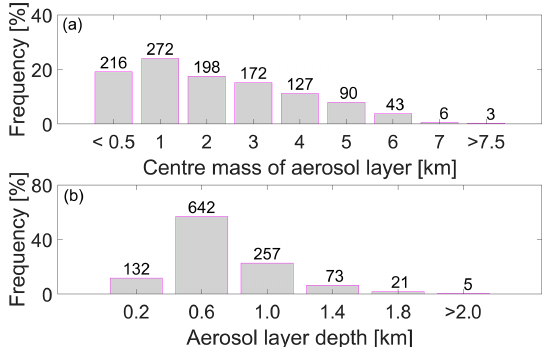
Figure 4. Geometrical characteristics and optical properties of the detected night-time aerosol layers located in the boundary layer (BL aerosol layers; in red) and free troposphere (FT aerosol layers; in green). (a) Centre of mass height of the aerosol layers. (b) Geomet- rical depth of the detected layers. (c) Layer aerosol optical depths (AODs) at 355. (d) Contribution of BL (red) and FT (green) aerosol layers to the total